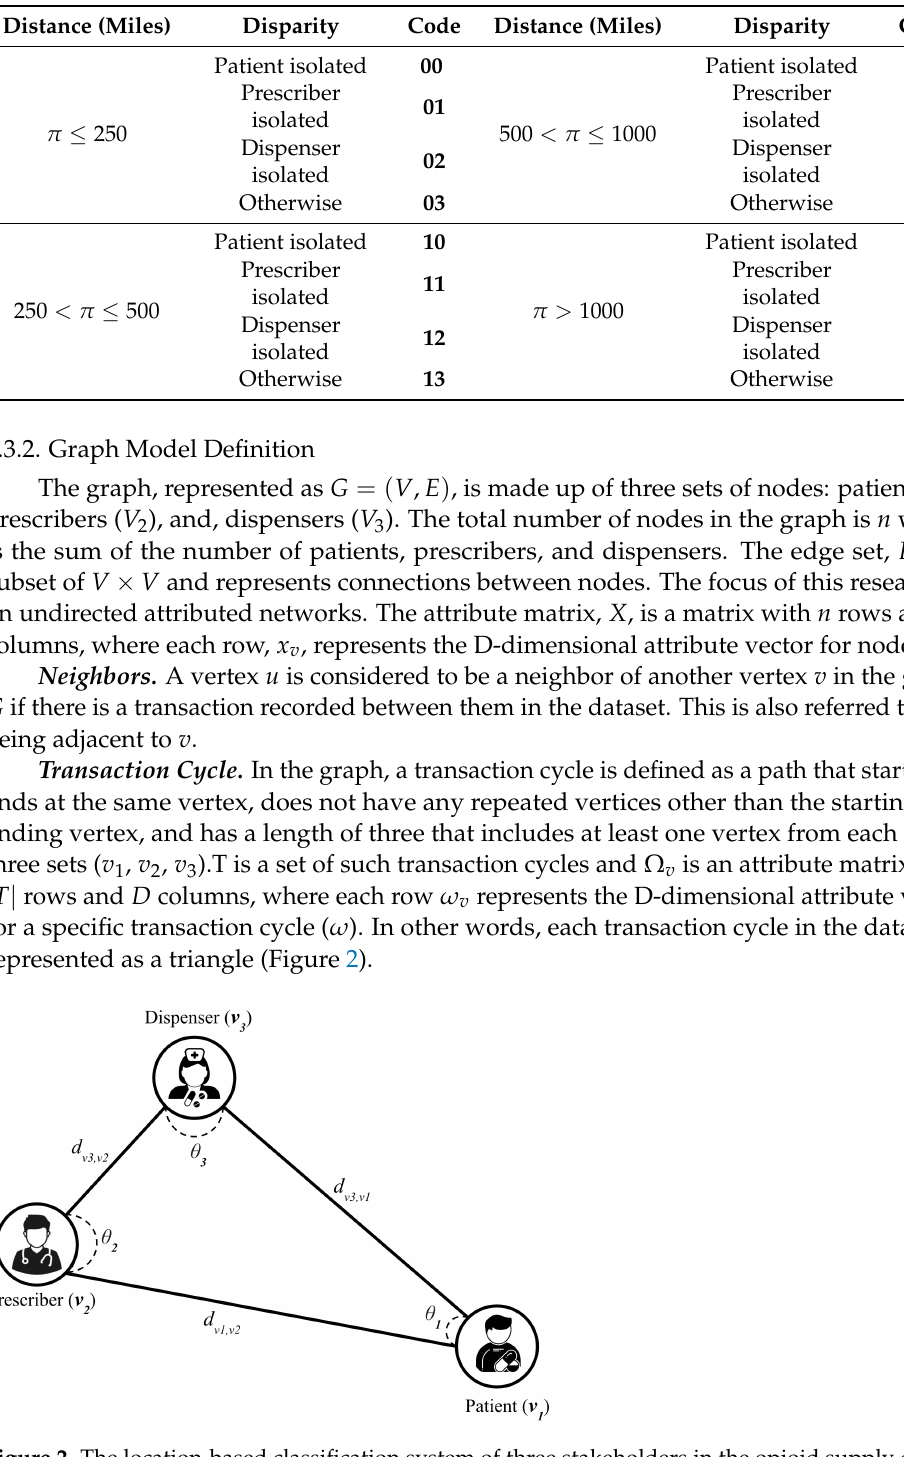
Table 1. Classification system illustration.